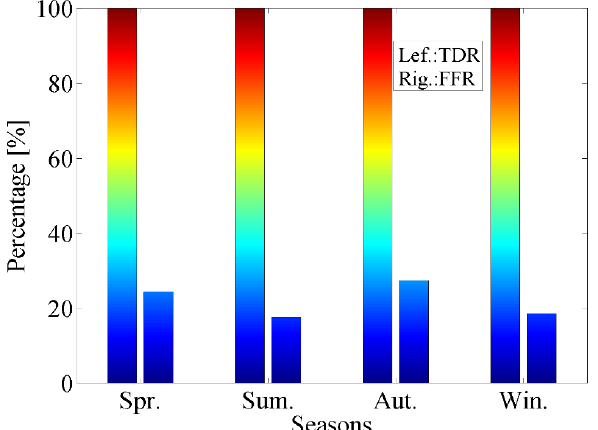
Figure 8. Average TDR and FFR of rainfall forecasts at eight stations in four seasons.